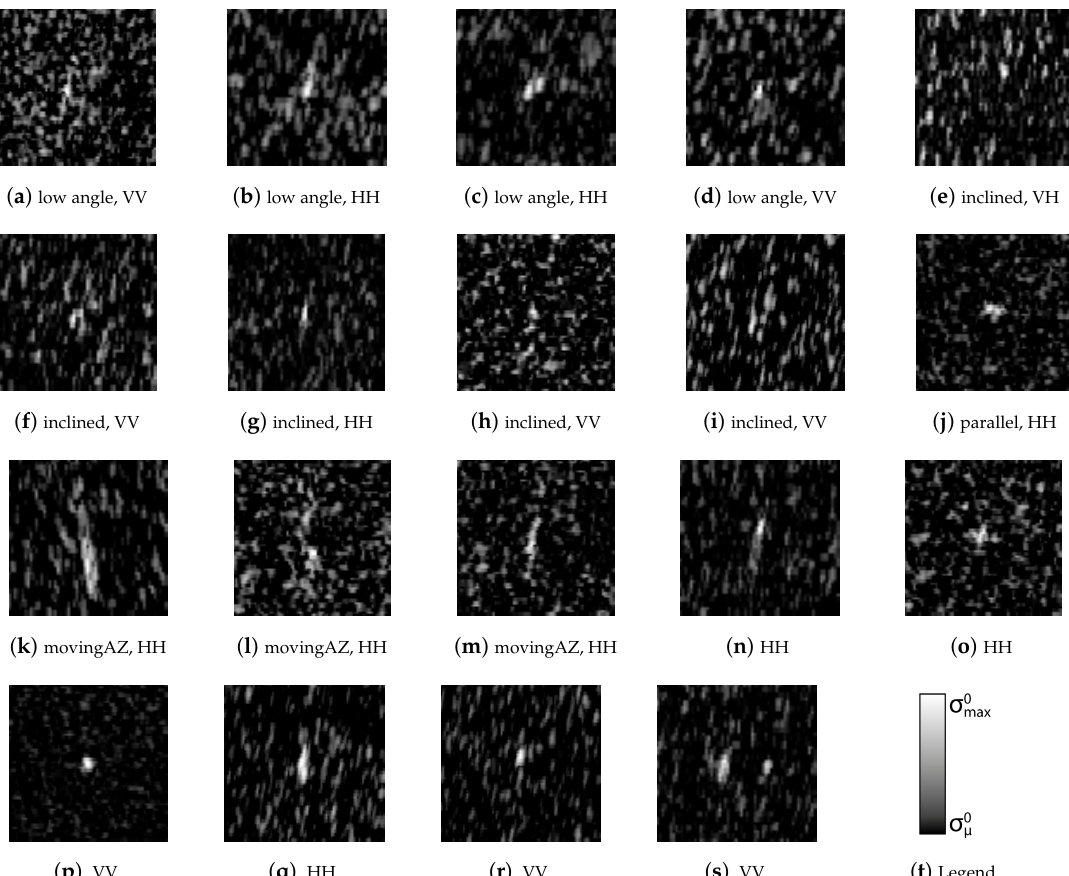
Figure 6. The vessel’s radar footprint in TSX-SM mode (©DLR, 2017) with indications for polarization and special scene or sensor settings.